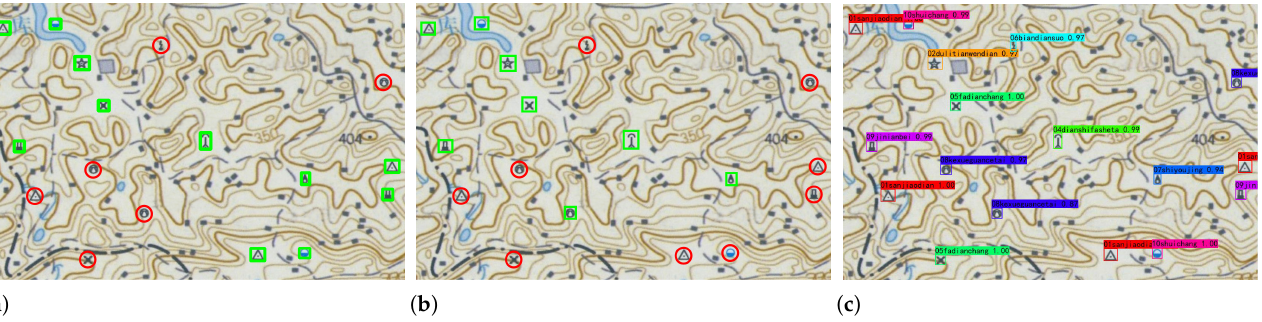
Figure 21. Recognition results of different methods for Map G. ( a ) Results of Template matching. ( b ) Results of GHT. ( c ) Results of the proposed ASPP-YOLOv4. In ( a , b ), the green box indicates correct recognition, whereas the red circle indicates missed